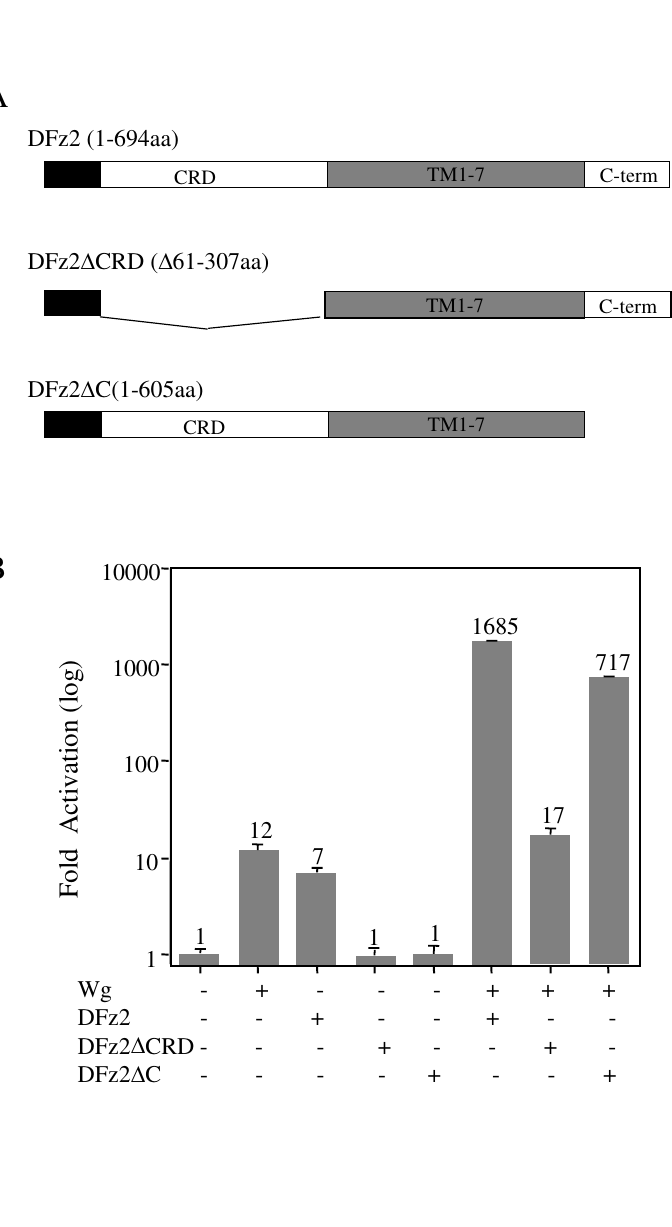
The synergy between Wg and DFz2 requires the CRD domain, but not the carboxyterminus of DFz2. (A) Dia- gram of the full-length DFz2 and its truncation constructs with deleted CRD domain or carboxyterminus. (B) S2 cells were transfected with indicated expression plasmids. Fold activation values were measured relative to the levels of luciferase activity in cells transfected with empty vectors and normalized by Renilla luciferase activities. These values are plotted as a log function. Averages of the fold activation are indicated above each column. All experiments were done in triplicate; error bars represent standard